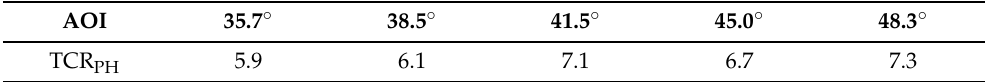
Table 6. Mean TCR values (in dB) estimated for the PH at the five AOIs.